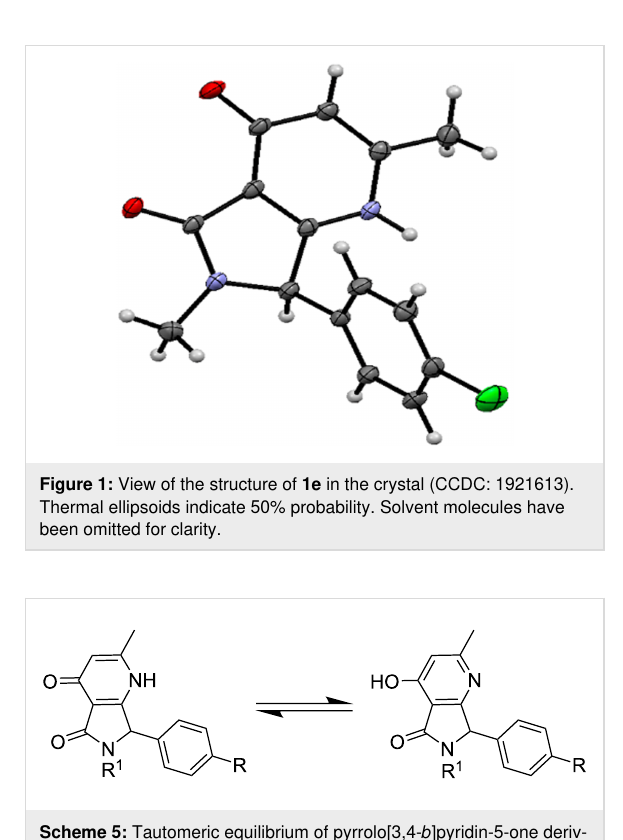
pyrrolo[3,4- b ]pyridin-5-one scaffold. In addition, single